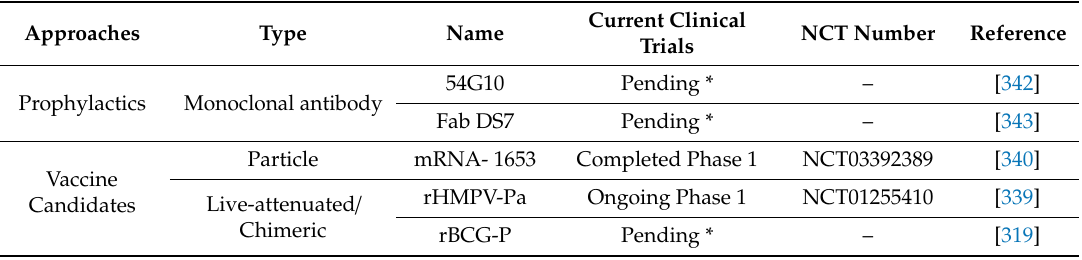
Table 10. Ongoing studies of prophylactic treatments and vaccine candidates against